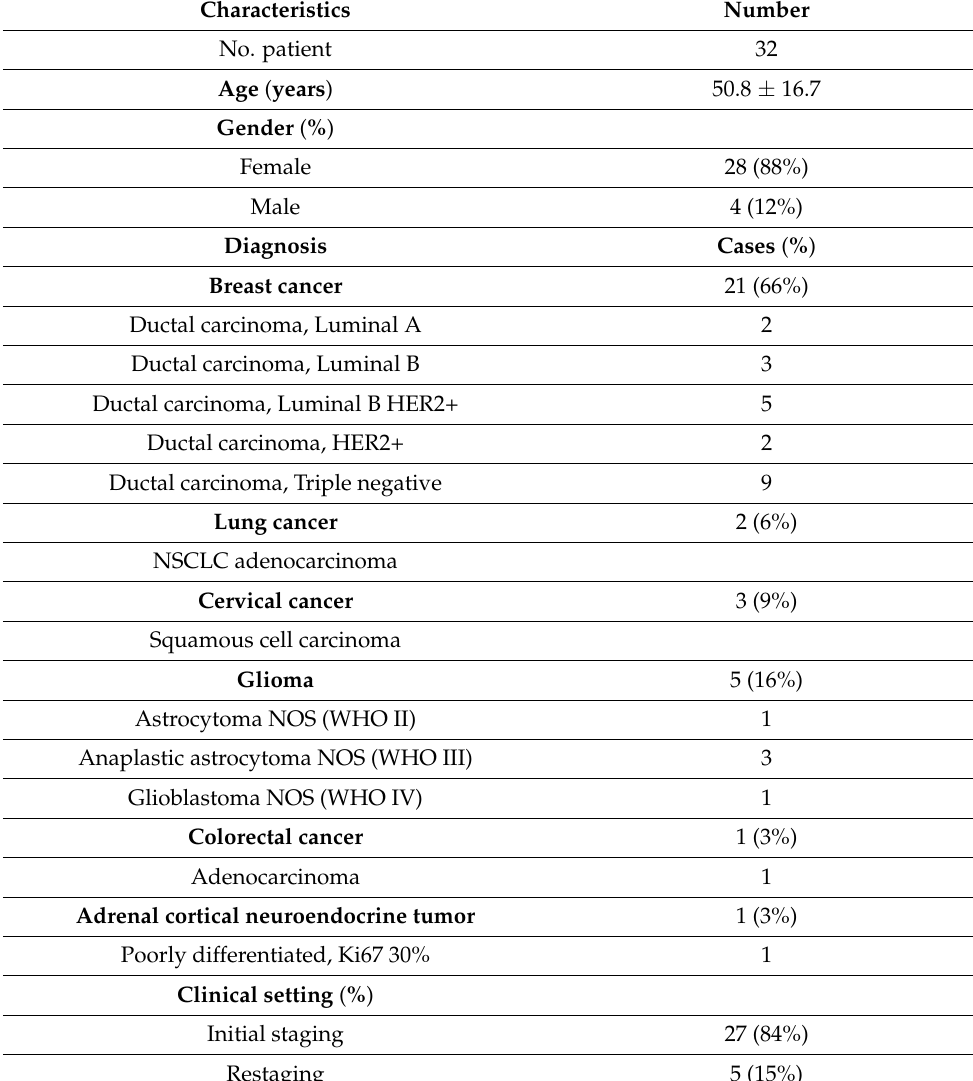
Table 1. General characteristics of the patients included in the [ 99m Tc]Tc-iFAP imaging study.